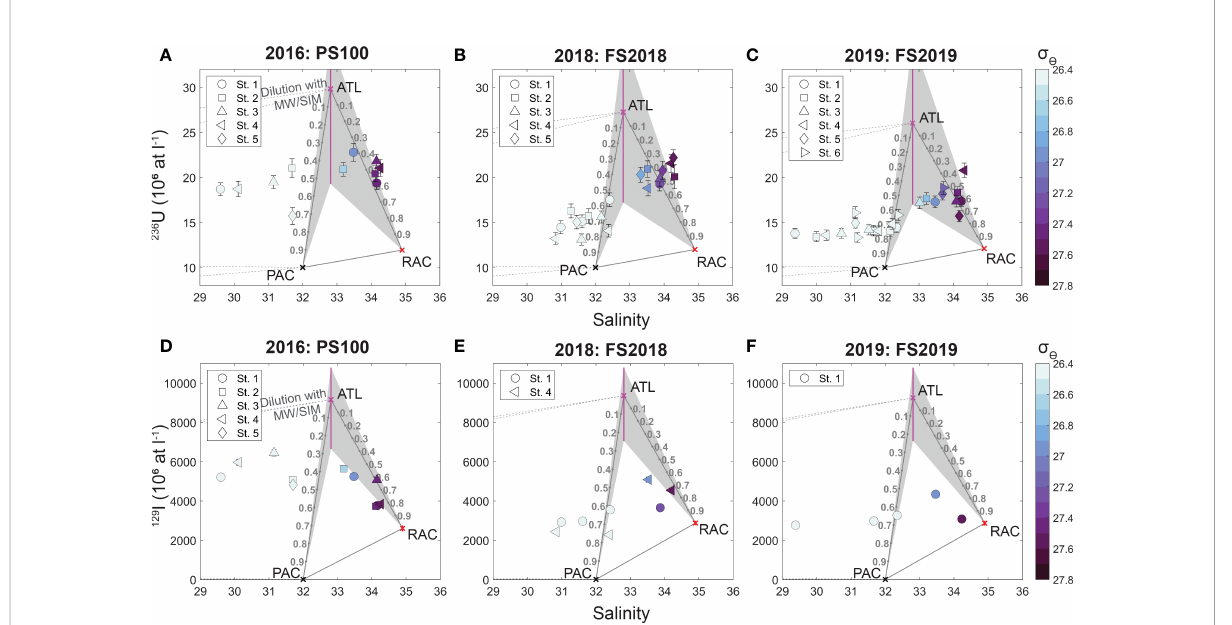
FIGURE 7 236 U-Salinity (A – C) and 129 I-Salinity (D – F) steady state mixing models for 2016, 2018, 2019. PSW samples from matching stations between the three sampling years (Figure 4A) are plotted on top, color coded by potential density ( s Q ). Numbers along the PAC-ATL and RAC-ATL mixing lines denote fractions of PAC and RAC waters, respectively. Note the better data coverage for 236 U compared to 129 I. Different symbols refer to different stations. Acronyms are explained in Table